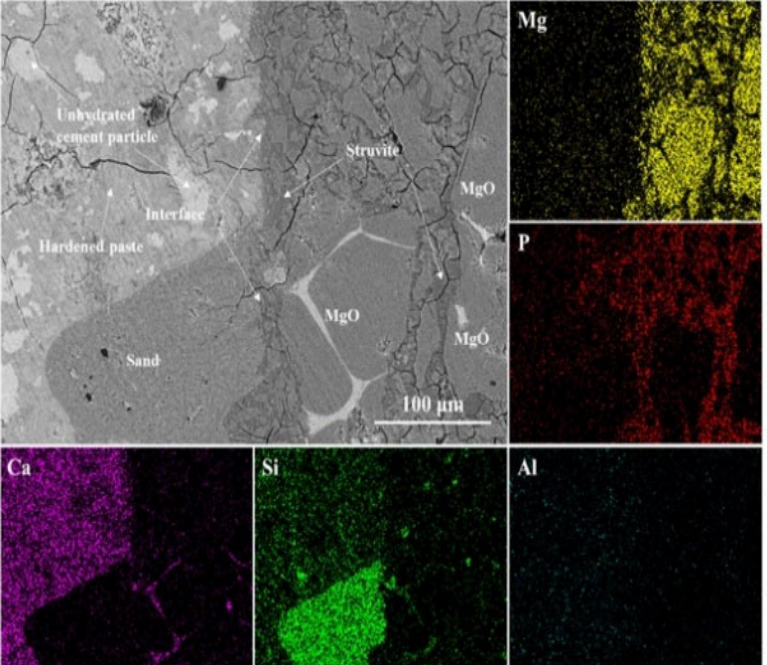
Figure 12. Backscattered electron image and elemental maps of the interface between old OPC substrate and MPC matrix, (M/P = 6) [59]. (Adapted and reprinted with permission from ref. [59], © 2018, Construction and Building Materials .).